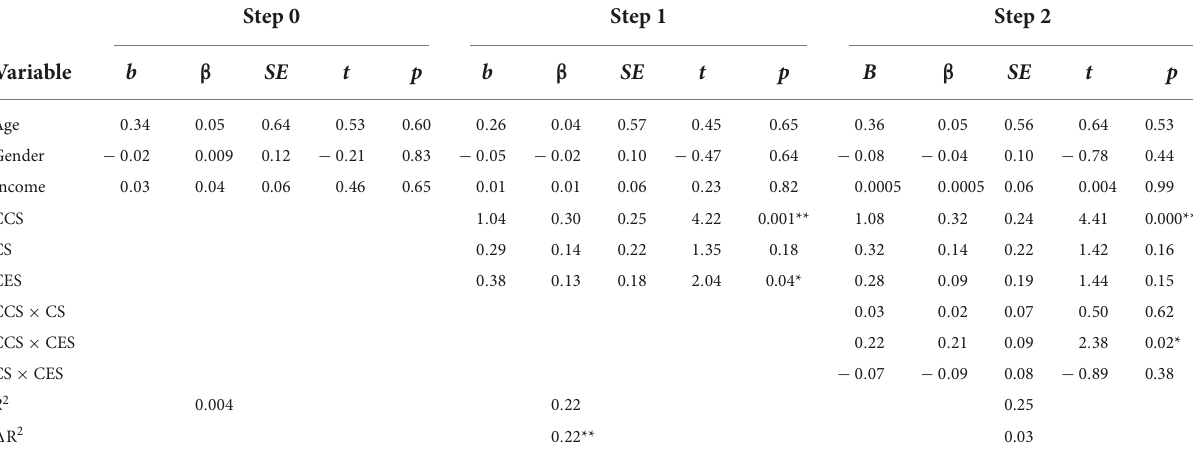
TABLE 4 Ethnic-racial socialization’s effect on political anti-racist action. Step